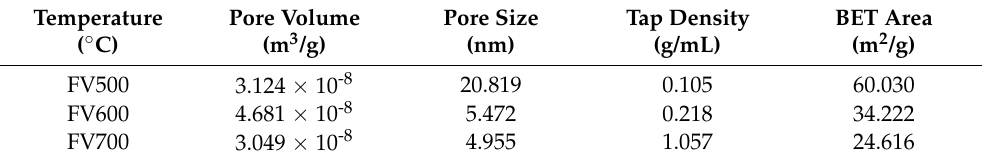
Table 2. Summary of the physicochemical properties of FV500, FV600, and FV700,